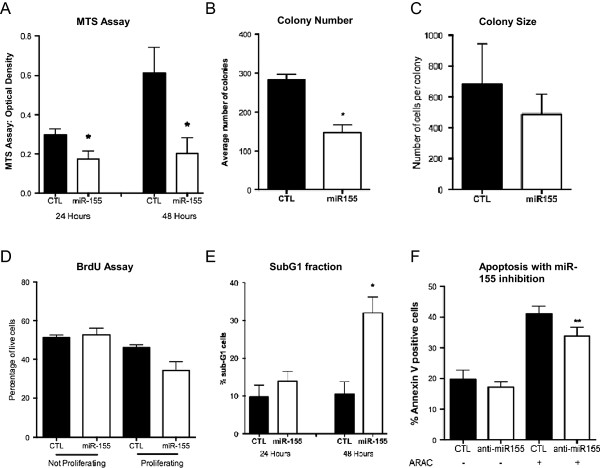
Growth perturbations in AML cells with altered miR-155 expression levels. (A) Transfection of OCI-AML3 cells with miR-155 resulted in a reduction of cell growth at 24 h and 48 h as determined by MTS assay (B) Assessment of colony forming potential found a decrease in mean colony number and (C) a trend towards reduced colony size (presented as mean + SEM cells per colony) (D) Proliferation through BrdU incorporation did not demonstrate a significant change (E) Cell cycle analysis demonstrated an increase in the proportion of cells in the SubG1 fraction at 48 h post miR-155 overexpression. CTL, Scrambled Control (F) Transfection of OCI-AML3 cells with anti-miR155 LNA resulted in a significant decrease in the proportion of cells undergoing apoptosis (AnnexinV+) when treated with ARAC, but not when untreated. ARAC-cytarabine arabinoside; LNA-locked nucleic acid; CTL, Anti-Scrambled LNA. Statistical significance determined using Paired Two Tailed t-Test, *p < 0.05 ** p < 0.001; n = 3-4.